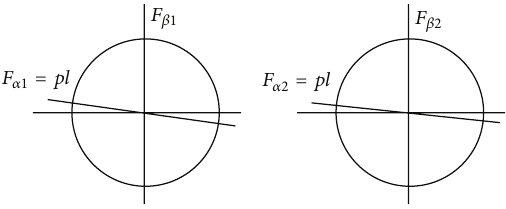
Figure 1: Coincident vertical principal meridians whose powers are different are found on the surfaces of a thick lens. Near-horizontal noncoincident meridians have plano